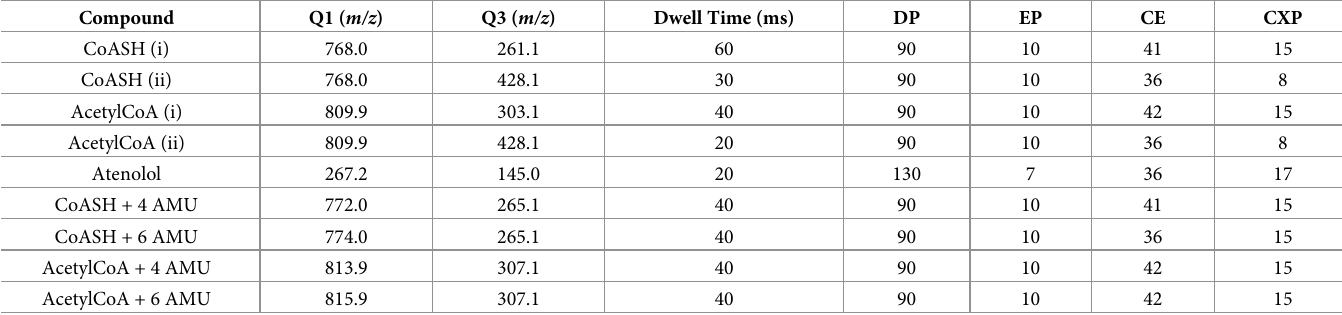
C57/Bl6 mouse brain depleted of endogenous CoASH and acetylCoA. The brain was kept at room temperature for 2 days, then homogenised in 4 volumes (w/v) of IS-WS 70/30 MeOH/50 mM ammonium acetate pH 6.0 with a Precellys 1 24 homogenizer. The homogenate was cen- trifuged at 4˚C at 16,000 rcf for 15 min and then the supernatant was divided into 40 μ L ali- quots and spiked with 10 μ L of acetylCoA/CoASH spiking solution for CSs and QCs.